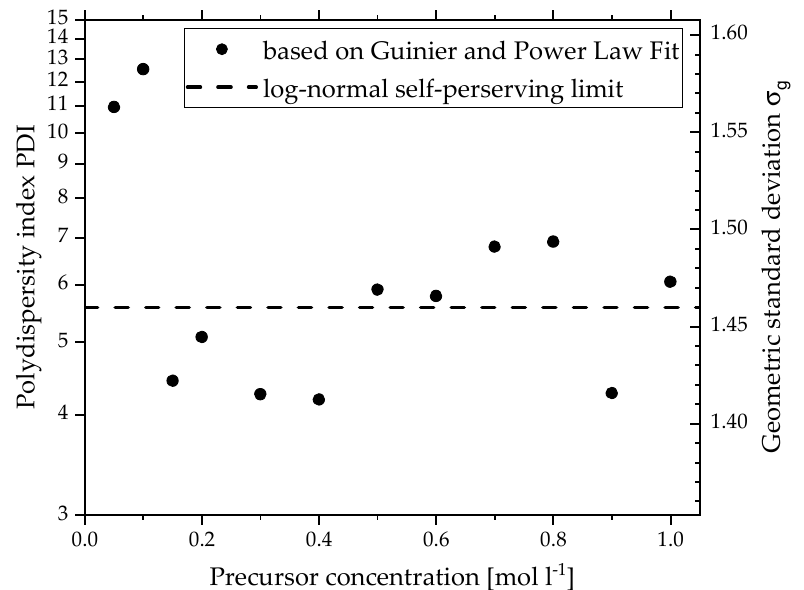
Figure 3. Polydispersity index and geometric standard deviation calculated from SAXS data using Equation (4) of primary particles made by SFS from different precursor concentrations.